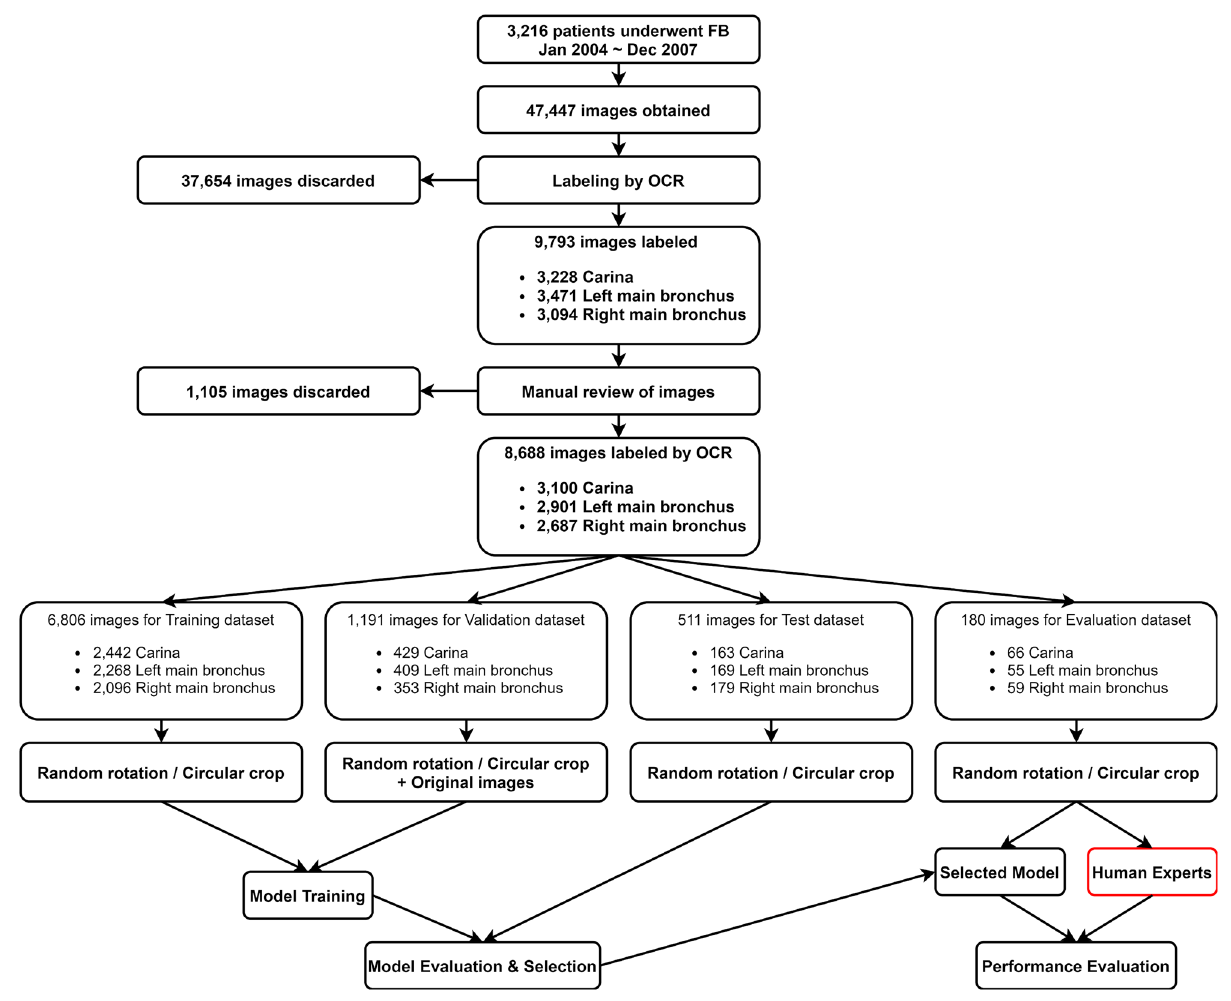
Figure 1. Image preprocessing. Images were labeled automatically by an optical character recognition engine. Recognized text strings were classified as the carina, left main bronchus, and right main bronchus classes. Only a square area containing the bronchoscopic view was cropped, and the rest, including patient-related information, was removed. All images were resized to 224 by 224 pixels and randomly rotated and cropped to a circle of random radius.